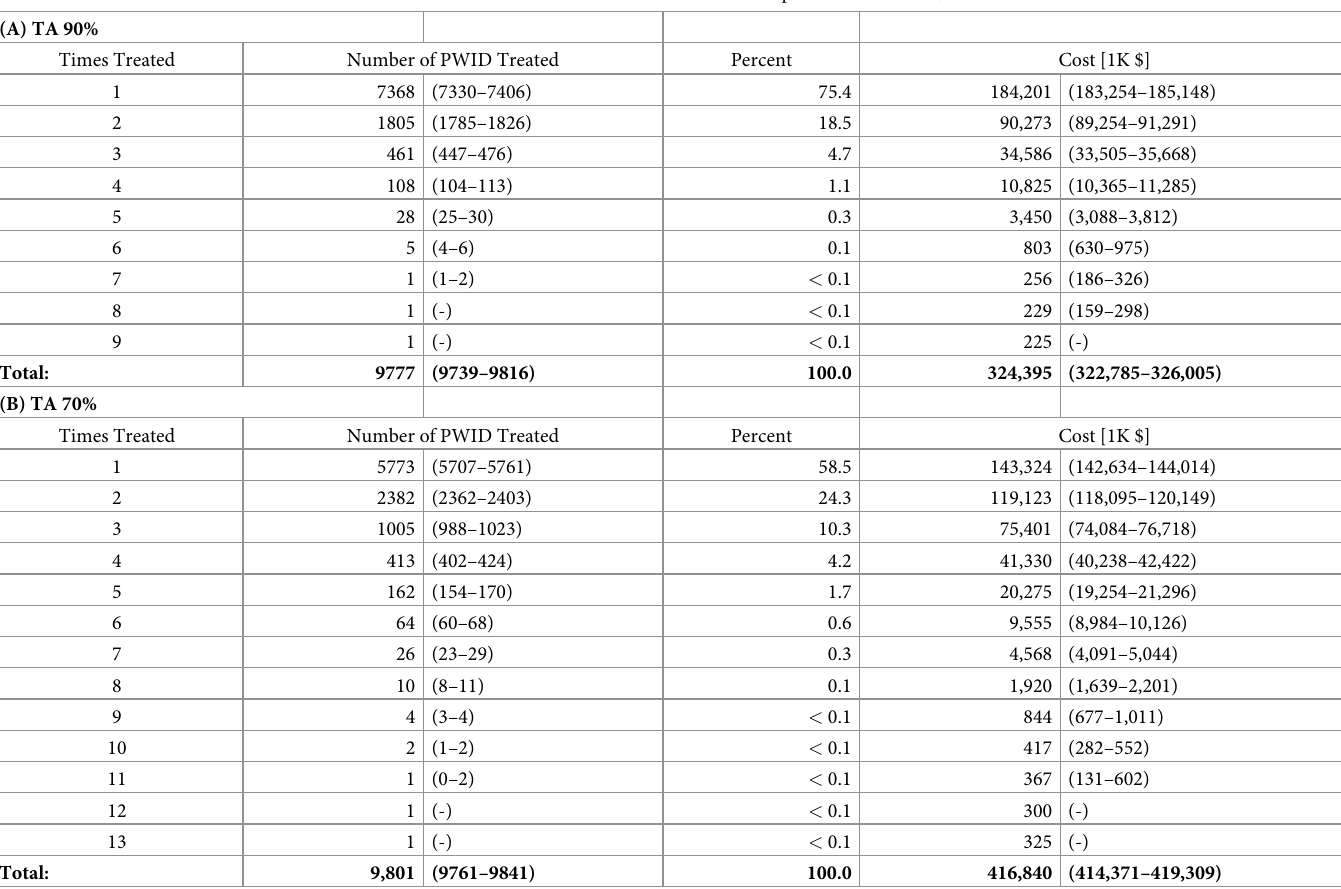
Table 2. Mean PWID treatment enrollment frequency and DAA costs (95% CI) for DAA treatment rate of 7.5% per year with unrestricted DAA courses permitted and a treatment adherence (TA) of 90% (A) and 70% (B). Number treated values are rounded to the nearest integer. Percent treated is the fraction of PWID treated by number of times in each row relative to the total number of all individual PWID treated. DAA cost per treatment is